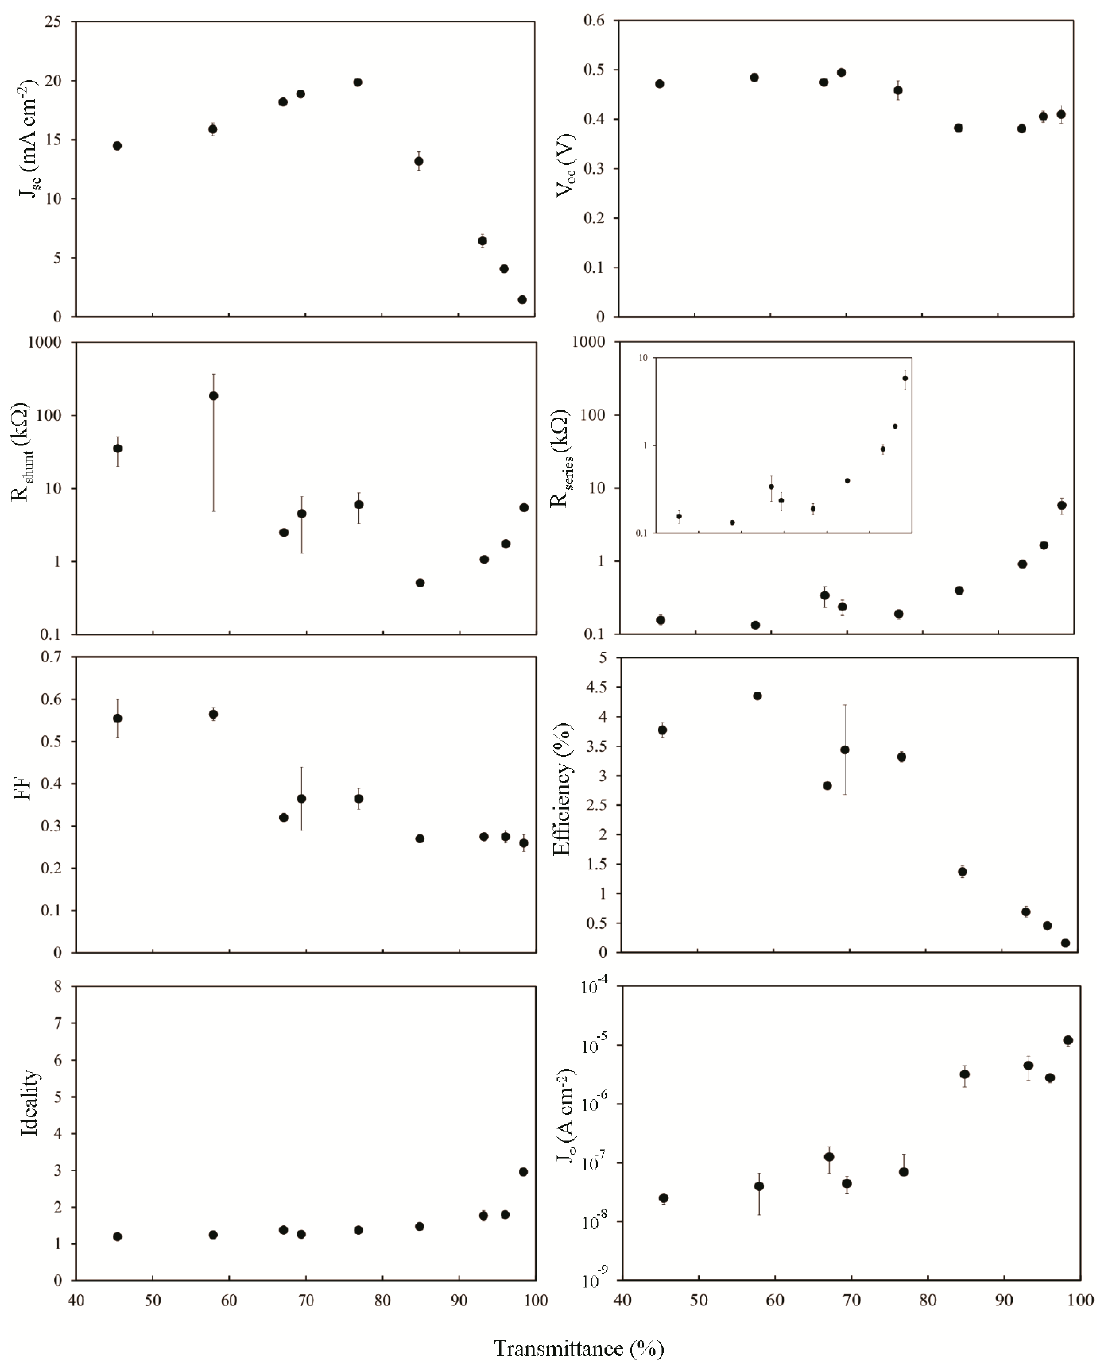
Figure 8. Solar cell parameters extracted from HF treated (second treatment) SWCNT-Si devices with varying SWCNT film thickness, 4 h after